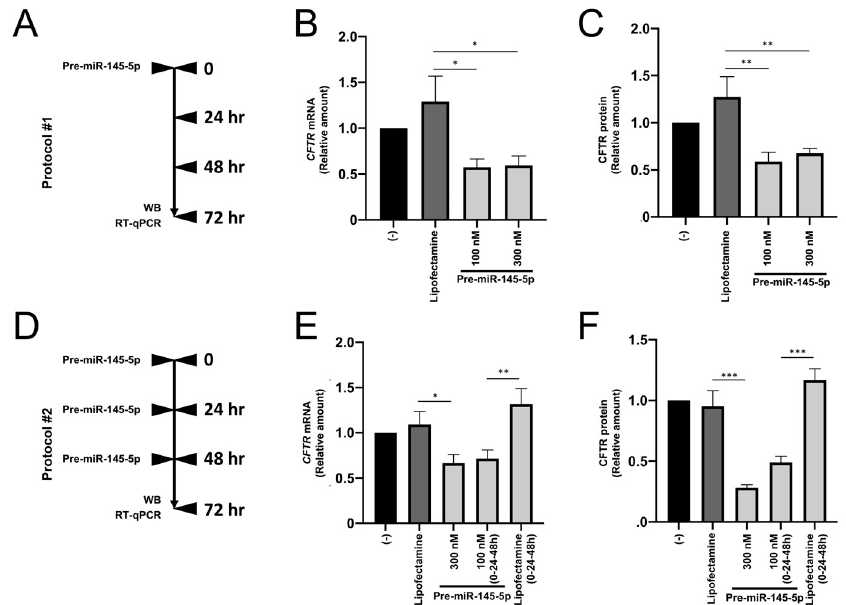
Figure 4. Effects of treatment of Calu-3 cells with pre-miR-145-5p, following protocol #1 ( A – C ) and protocol #2 ( D – F ). ( A ). Scheme of protocol #1. ( B ). Relative amounts of CFTR mRNA (RT-qPCR) in treated Calu-3 cells. ( C ). Relative content of the CFTR protein in treated Calu-3 cells. Treatment was 72 h (see panel A ). ( D ). Scheme of protocol #2. ( E ). Relative amounts of CFTR mRNA (RT-qPCR) in treated Calu-3 cells. ( F ). Relative content of the CFTR protein in treated Calu-3 cells. Treatment was 72 h (see panel D ). (-) = untreated cells. * p < 0.05, ** p < 0.01, *** p < 0.001.